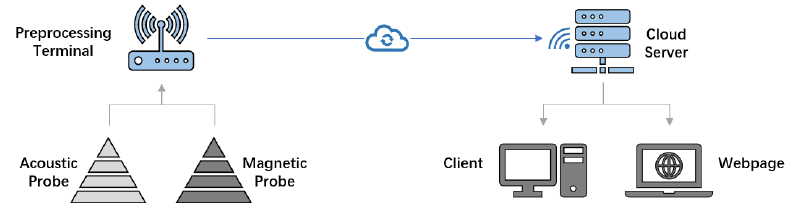
Figure 1. AETA system contains probe, station, server and UI of client and webpage.